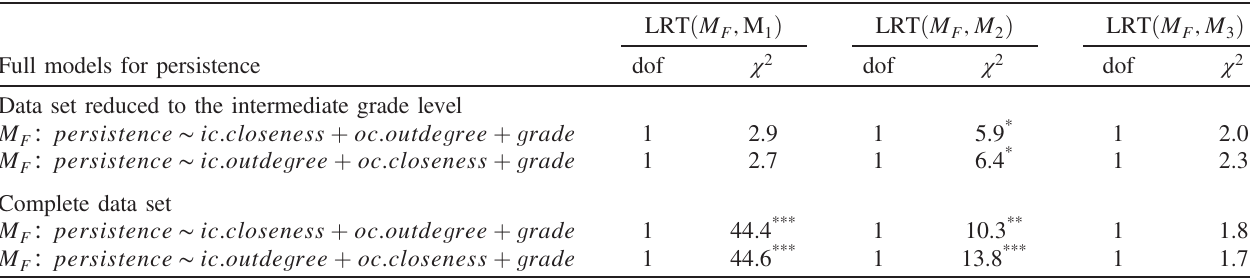
TABLE VI. Summary of the likelihood ratio test (LRT) for multiple logistic regression models. Comparison of the full models (with two centralities and final grades as predictors) with the reduced models. The analysis is performed for the intermediate grade level ( N ¼ 90 ) and for the full data set ( N ¼ 239 ). dof indicates degrees of freedom. Significant adjusted P values are marked with an